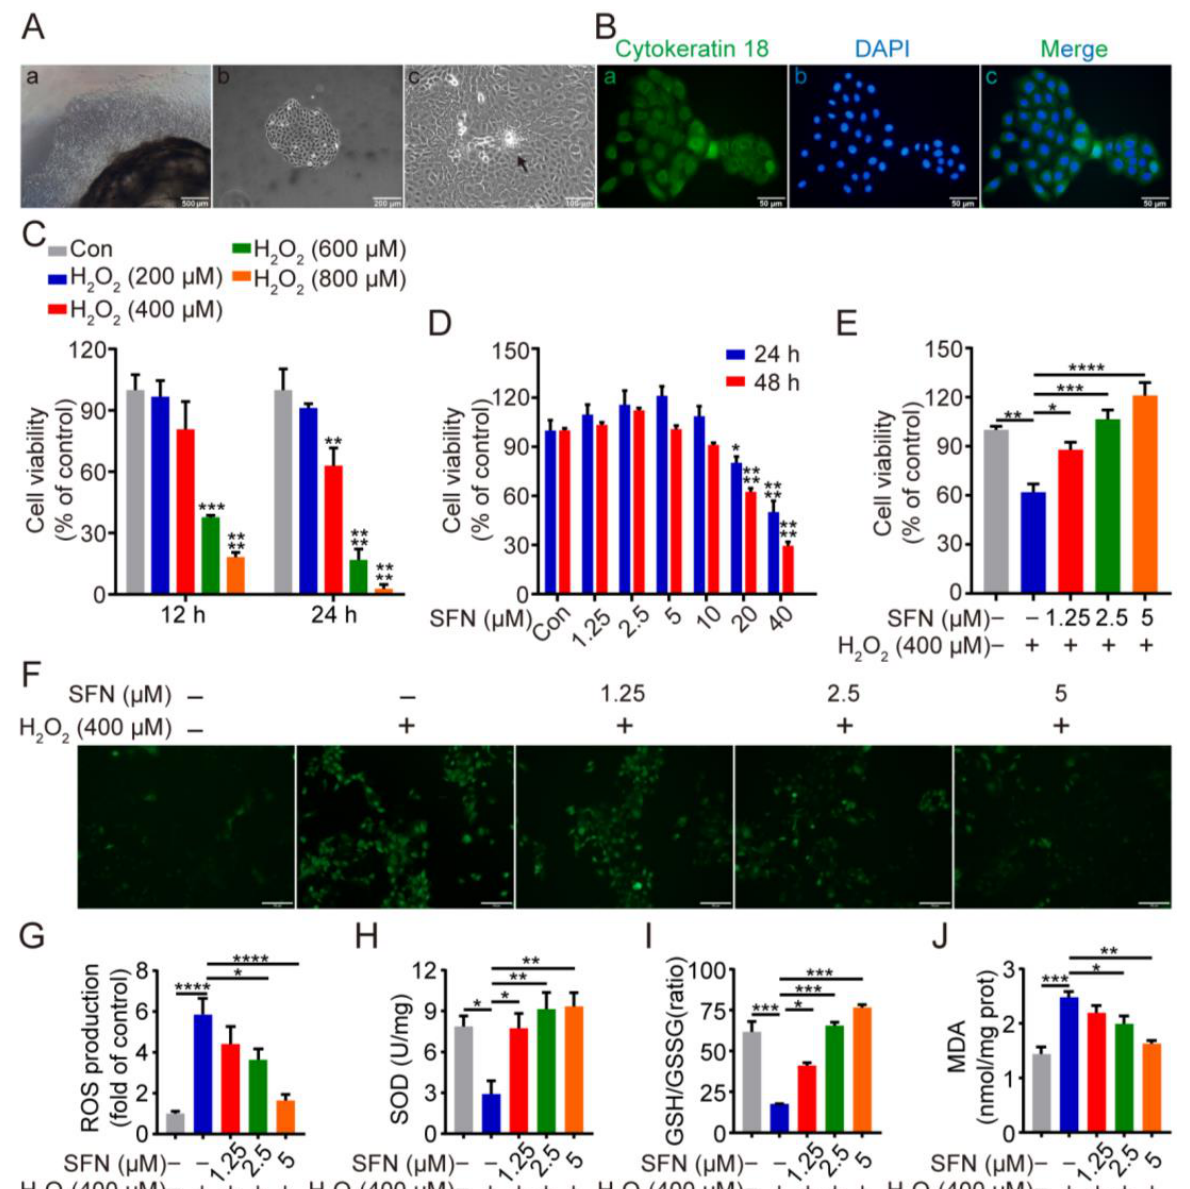
Figure 1. Sulforaphane (SFN) enhanced the antioxidant capacity in primary goat mammary epithelial cells (GMECs). Cells were treated with SFN (1.25, 2.5, 5 µ M) for 24 h before exposed to H 2 O 2 (400 µ M) for 24 h. ( Aa ) Primary goat mammary epithelial cells (GMECs) moved out of tissue block after culture for 8 days. Scale bars: 500 µ m. ( Ab ) GMECs for passage 1. Scale bars: 200 µ m. ( Ac ) Dome-like structures of GMECs (arrow). Scale bars: 100 µ m ( B ) Immunostaining analysis of cytokeratin 18 (CK18) ( Ba ) and nuclear staining with DAPI ( Bb ) in GMECs with merge image ( Bc ). Scale bars: 50 µ m. ( C ) Cell viability of GMECs after treatment with different concentrations of H 2 O 2 (0~800 µ M) for 12 h or 24 h. One-way ANOVA, Dunnett’s post hoc test. ( D ) Cell viability of GMECs after treatment with different concentrations of SFN (0~40 µ M) for 24 h or 48 h. One-way ANOVA, Tukey’s post hoc test. ( E ) Cell viability of GMECs after treatment with different concentrations of SFN (1.25, 2.5, and 5 µ M) for 24 h in the absence or presence of H 2 O 2 (400 µ M) for 24 h. ( F ) Reactive oxygen species (ROS) production was detected by the fluorescence intensity of 2,7-Dichlorodihydrofluorescein diacetate (DCFH-DA) using fluorescent microscope. Scale bars: 50 µ m. ( G ) Quantification of ROS production. ( H – J ) Superoxide dismutase (SOD) activity, glutathione (GSH)/glutathione oxidized (GSSG) ratio, and malondialdehyde (MDA) production were detected in different groups. One- way ANOVA, Tukey’s post hoc test. Data are the mean ± SEM ( n = 3). * p < 0.05, ** p < 0.01, *** p < 0.001, and **** p < 0.0001. 2.2. SFN Inhibited H 2 O 2 -Induced Cell Apoptosis To evaluate the effect of SFN on cell apoptosis, flow cytometry and Western blotting were conducted. As shown in Figure 2A,B, flow cytometry showed that SFN pretreatment signifi- cantly decreased the rate of apoptosis compared with H 2 O 2 -treated cells. Furthermore, H 2 O 2 treatment upregulated the expression of Bax with a concomitant inhibition of BCL2 protein